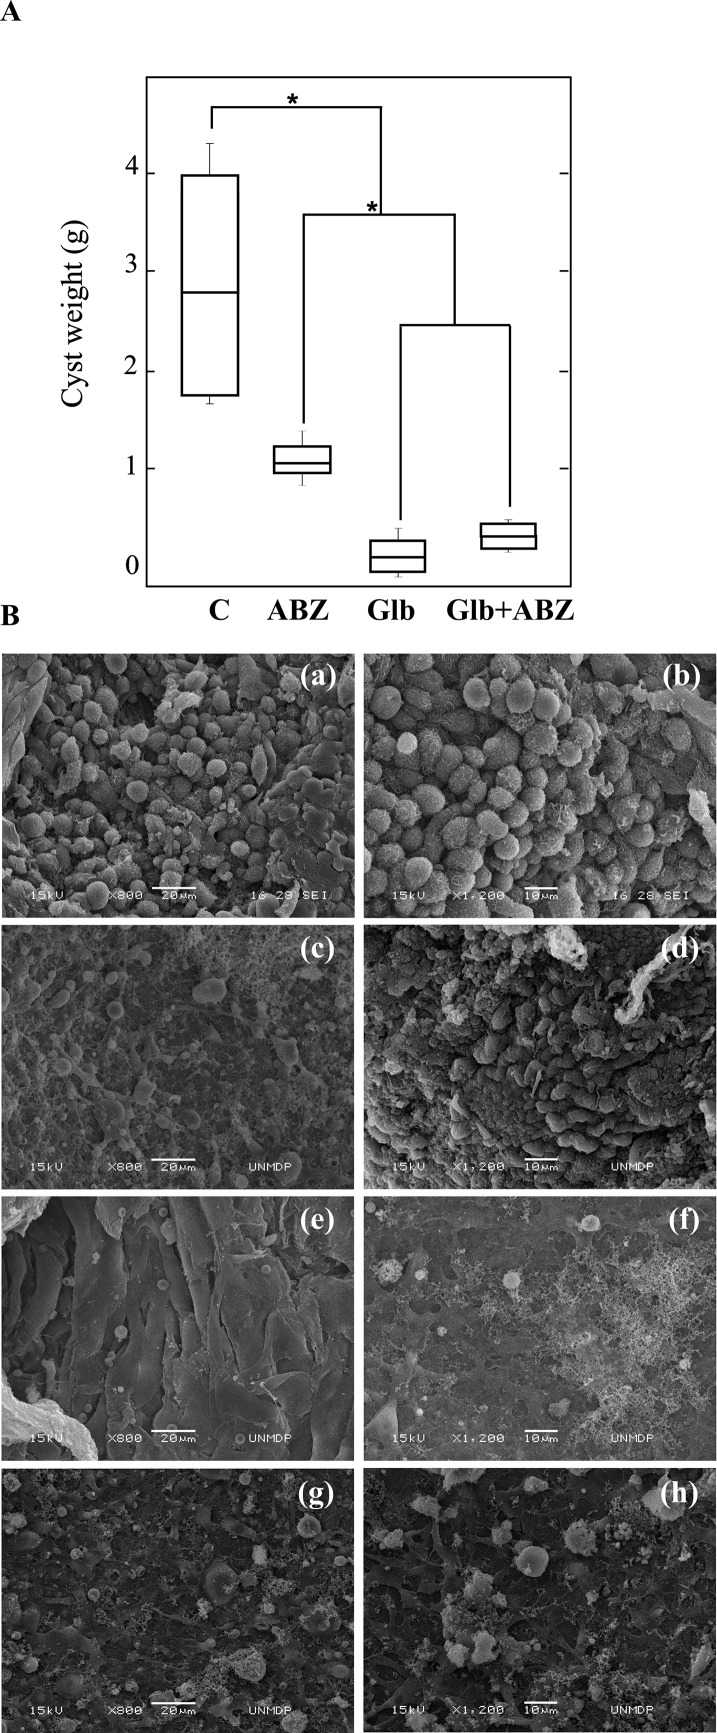
Therapeutic efficacy study in E. granulosus infected mice.(A) Box plots showing the comparative distribution of the weight (g) of cysts recovered from untreated mice (C) and treated with albendazole (ABZ, 5 mg/kg/d), glibenclamide (Glb, 5 mg/kg/d) and the combination of both drugs (Glb+ABZ) for 60 days. The weight of cysts was significantly decreased upon all treatments compared with the control (*p <0.05), but the decrease was more prominent in the groups receiving Glb alone or the combined treatment than that with ABZ alone (*p < 0.05). (B) Representative SEM images of hydatid cysts recovered from untreated mice (a, b) or treated with ABZ (c, d), Glb (e, f) and Glb+ABZ (g, h). Bars indicate: 20 μm in (a, c, e, g), and 10 μm in (b, d, f, h).